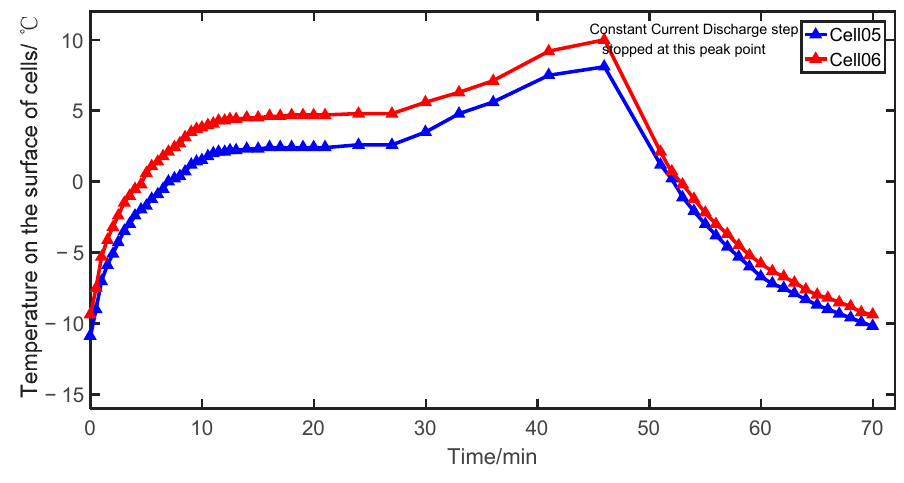
Figure 4. The temperature increase of the battery in the test.